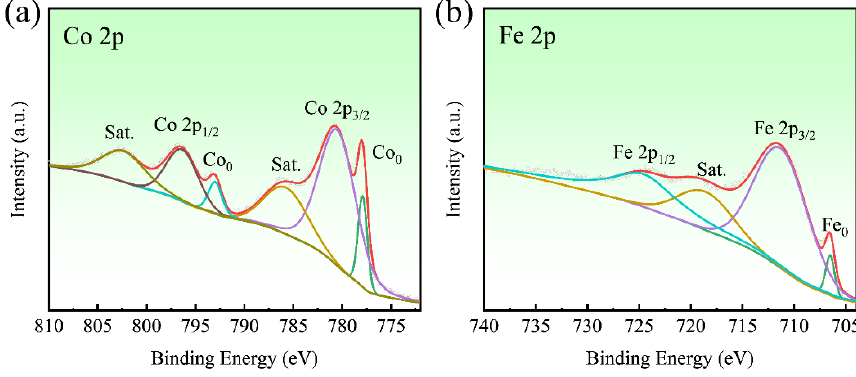
Figure 2. SEM image and EDS spectrum of Fe 35 Co 65 ( a , d ), Fe 22 Co 78 ( b , e ), Fe 15 Co 85 ( c , f ).